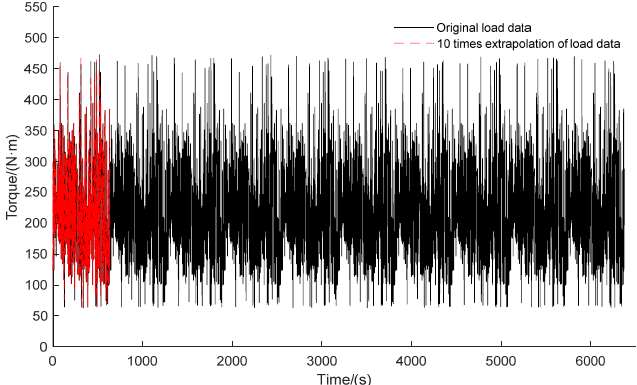
Figure 3. The comparison of original load time history and 10-times-extrapolated load time history.